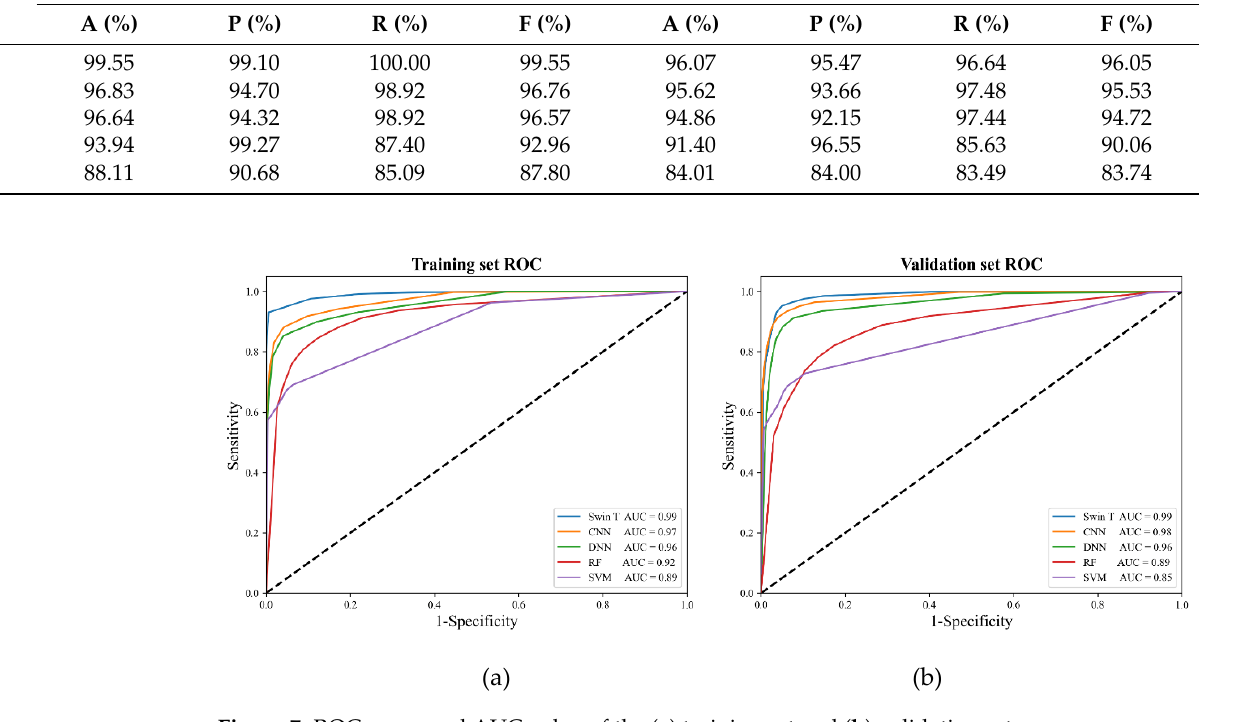
Figure 7. ROC curve and AUC value of the ( a ) training set and ( b ) validation set.